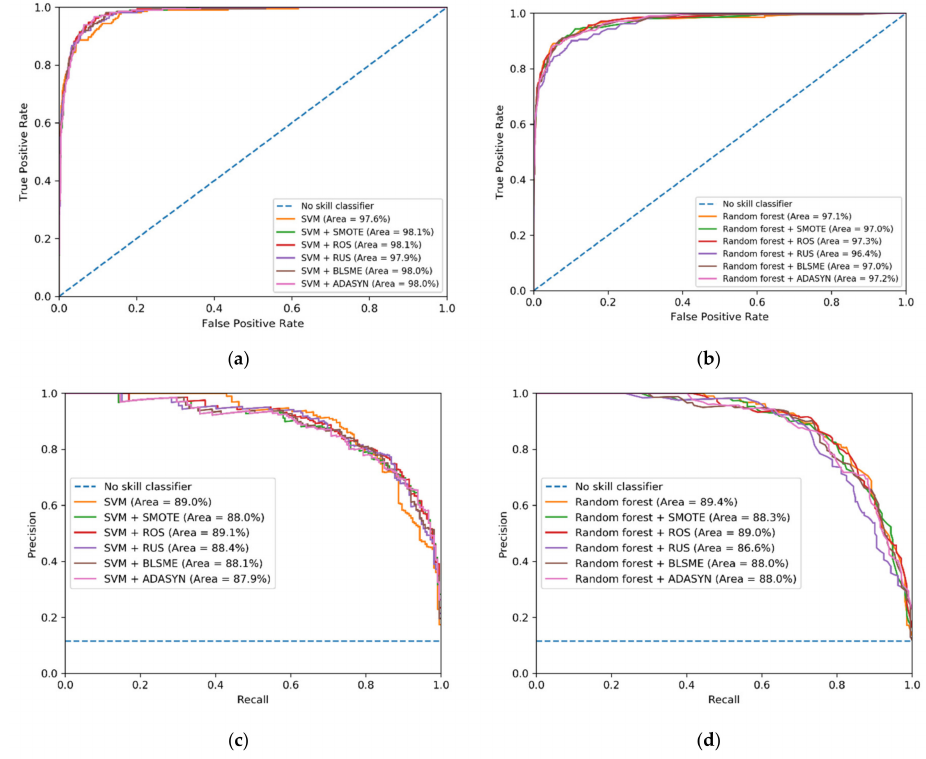
Figure A5. The ROC and PR curves of SVM and Random Forest for Fold 4; ( a ) the ROC curve of SVM; ( b ) the ROC curve of Random Forest; ( c ) the PR curve of SVM; and, ( d ) the PR curve of Random